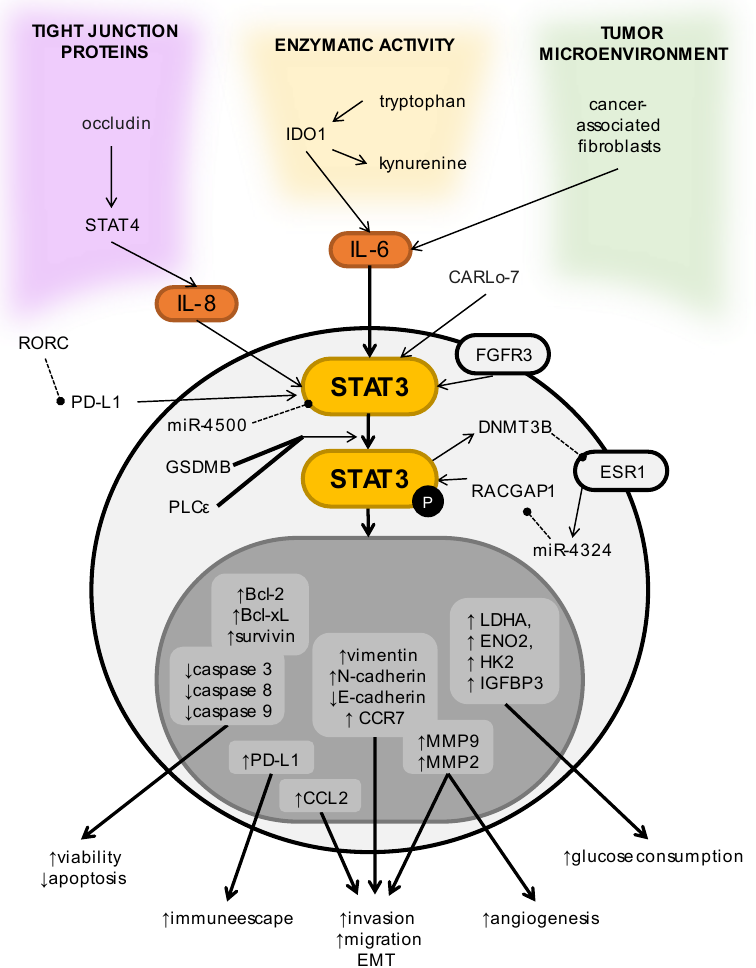
Figure 3. Schematic and simplified depiction of selected pathways and factors regulating STAT3 expression, counting its downstream target proteins, with the consequences of their overexpression in bladder cancer. Dashed lines ending with a dot show inhibition; arrows show stimulation.